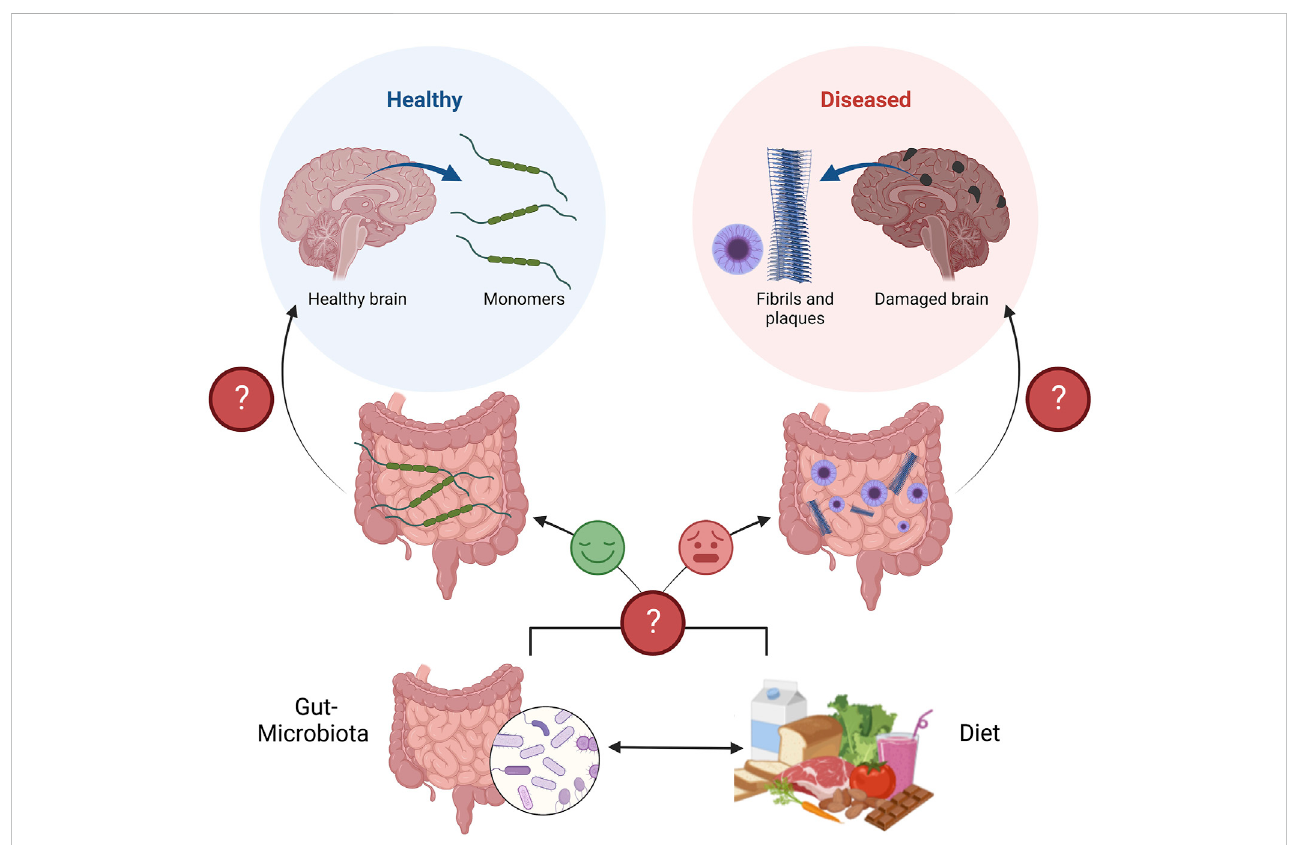
FIGURE 1 Schematic of the diet-microbiota-gut-brain axis in the context of neurodegenerative diseases. The gut, and gut-microbiota are known to secrete protective neurotrophic factors to promote brain health, neuron survival, and plasticity (Left path). If gut metabolism is perturbed, due to altered communicationbetweenthegut,andgut-microbiota,bothin fl uencedbythediet,theseprotectivefactorsmaynotbesecretedorfunctionasintended(Right path). Perturbed gut metabolism corresponds to the appearance of neurodegenerative pathologies (Fibrils and plaques), years before appearing in the brain and causing disease. Figure constructed on